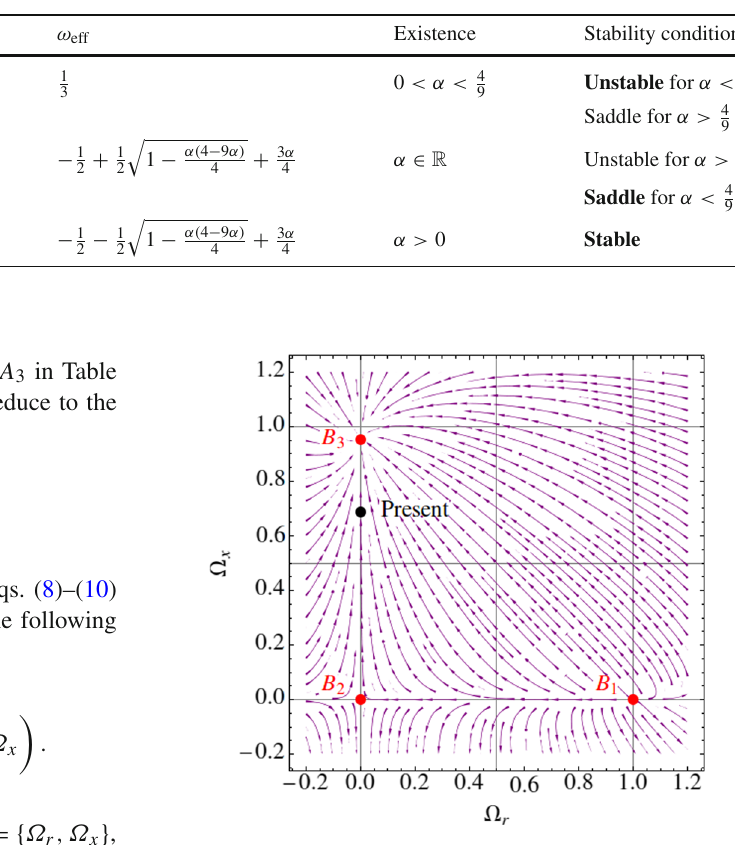
Fig. 2 Phase plot for model Γ 1 x with α = 0 .